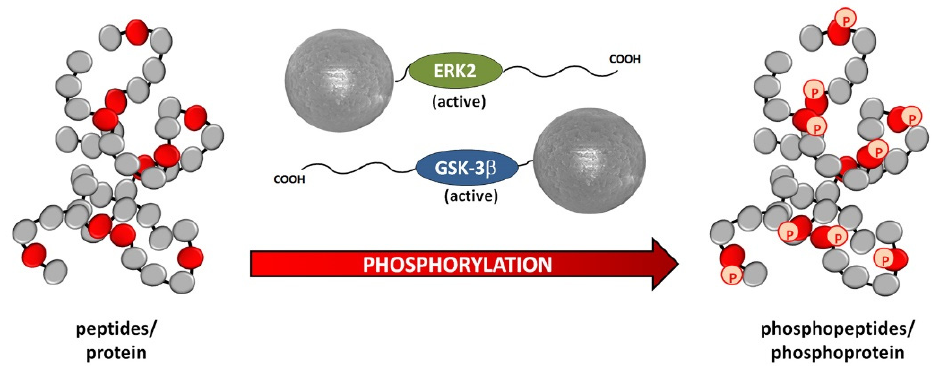
Figure 5. Sequential in vitro phosphorylation of recombinant tau protein by a system of two immobi- lized active kinases. The prephosphorylation of the tau protein was provided by immobilized ERK2, followed by phosphorylation by immobilized GSK-3 β [59].